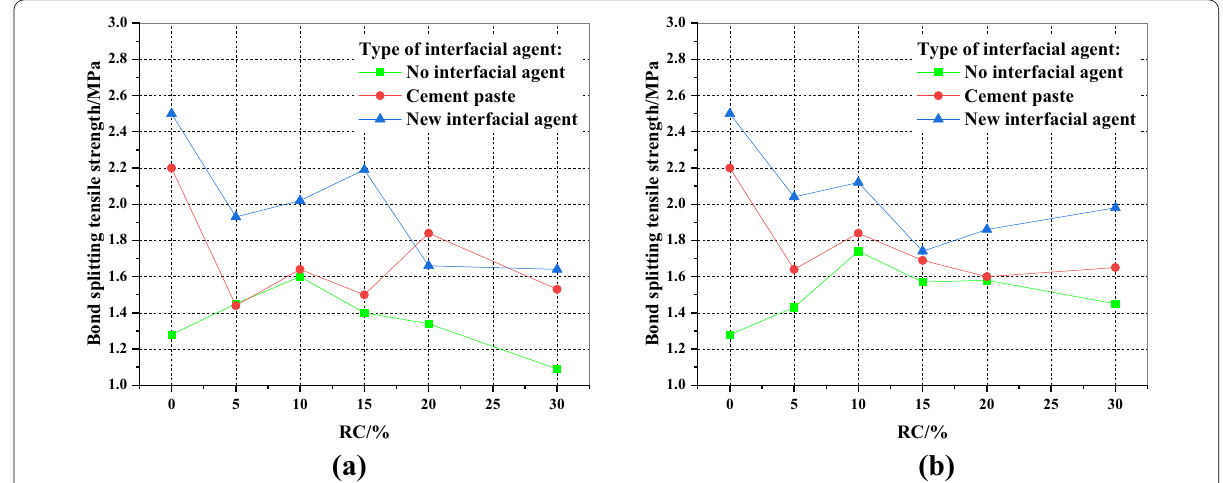
Fig. 9 Relationship between the bonding splitting tensile strength and the RC with a 1–3 mm RPs and b 3–5 mm